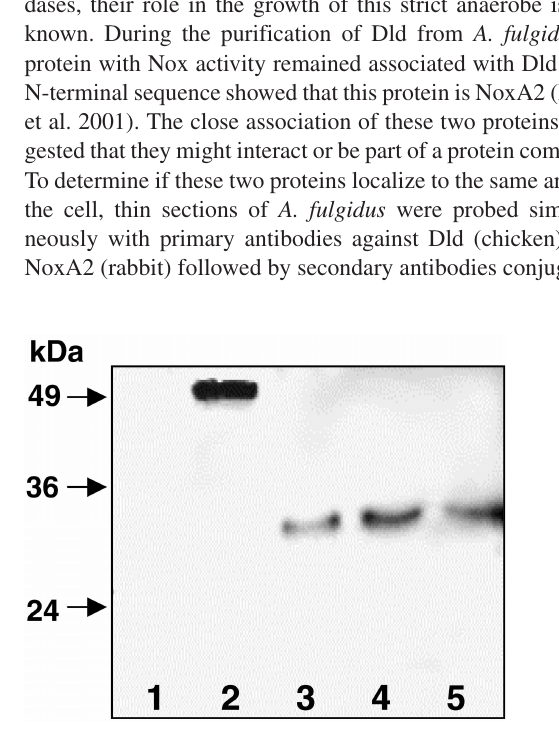
Figure 3. Portions of Dld are vulnerable to protease digestion. Whole cellswere treatedwith proteinaseK and the size of Dld remainingwas analyzed by immunoblot. Lane 1: wash from untreated whole cells; Lane 2: untreated whole cells; Lanes 3–5: whole cells treated with proteinase K for 10 (Lane 3), 20 (Lane 4) and 30 min (Lane